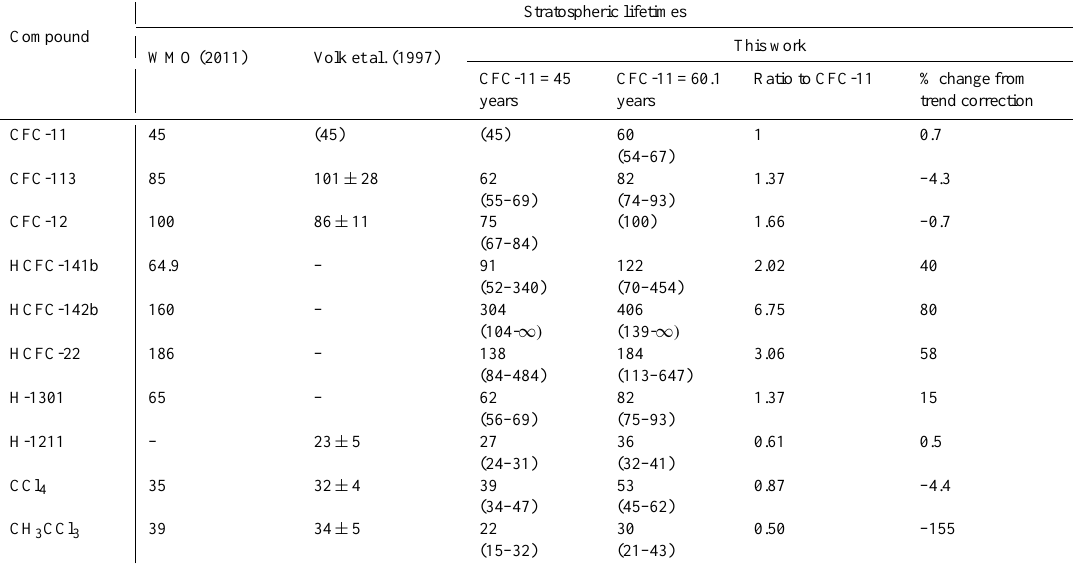
Table 2. Comparison of stratospheric lifetimes from WMO (2011), Volk et al. (1997) and this work. The latter two were scaled relative to a CFC-11 lifetime of 45 years. The CFC-11 lifetime of 60.1 years in our work results from assuming a CFC-12 lifetime of 100 years. The uncertainty ranges were derived via Eq. (6) by considering the slope uncertainty in the CFC-11–mean-age correlation as given in the text, slope uncertainties in tracer-CFC-11 correlations (see the Supplement), and values of 0.7 to 1.75 for 3 . To ensure comparability with the work of Volk et al. (1997), we adopt a 3 value of 1.25 for our lifetime calculations.